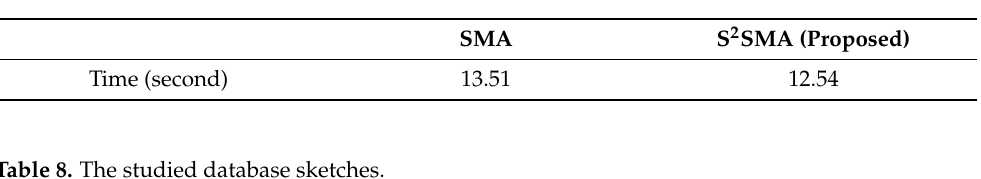
Table 7. Computational time analysis.